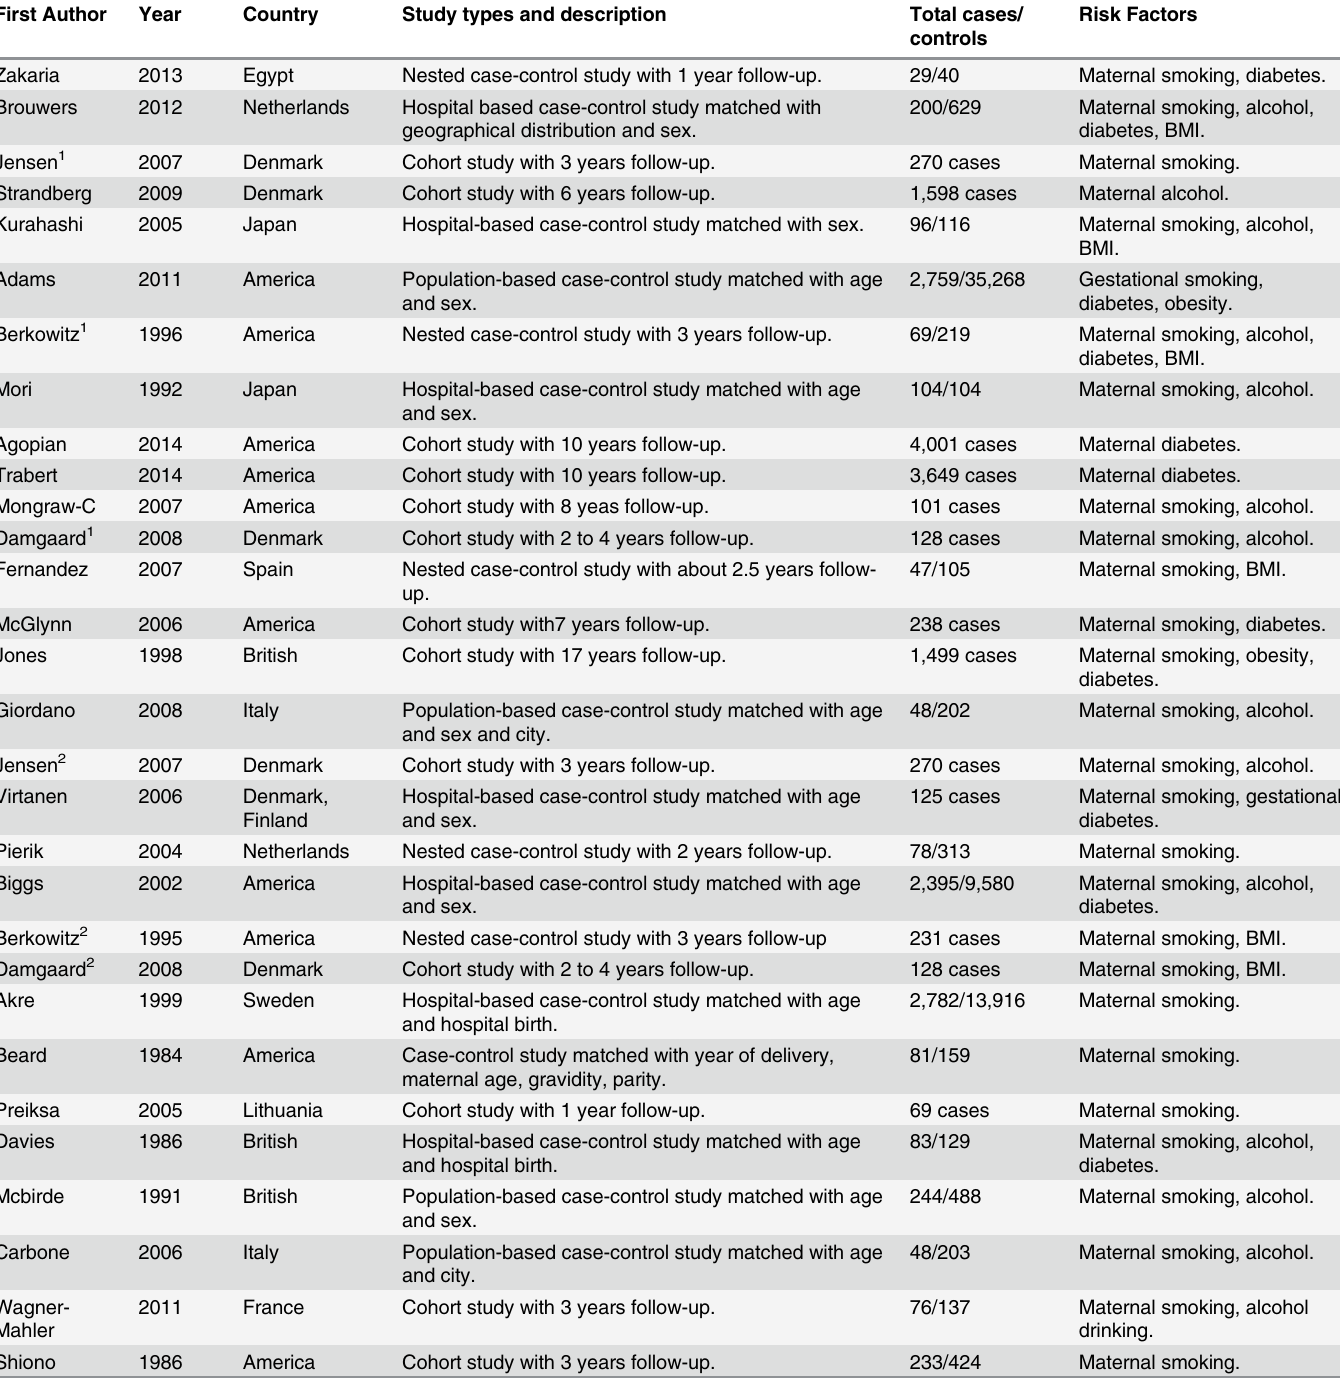
Table 1. Characteristics of included studies in the